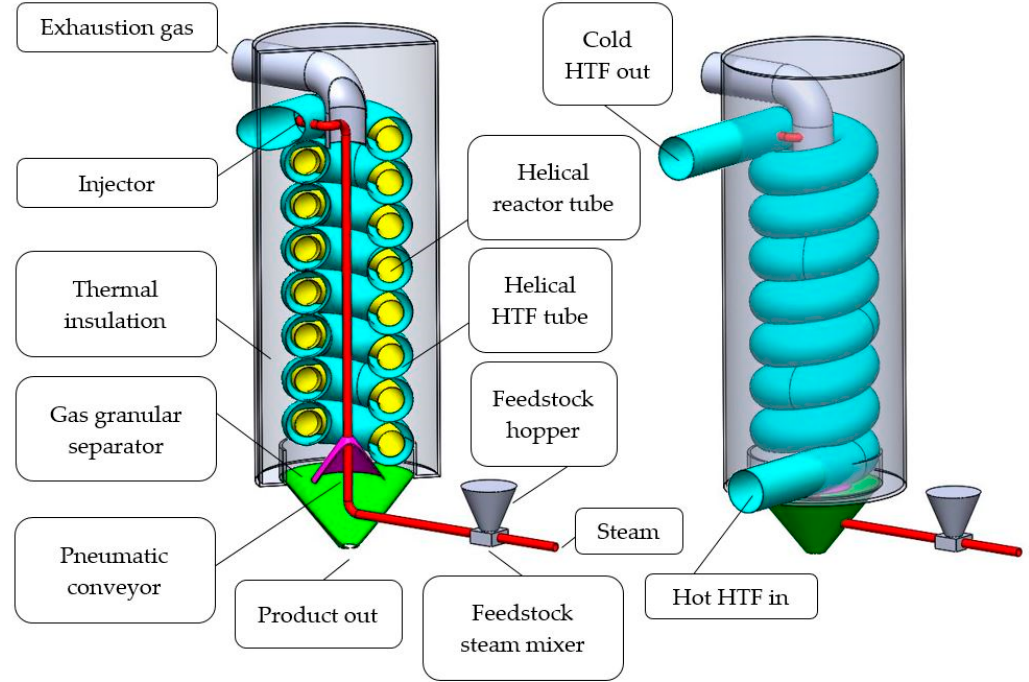
Figure 2. Isometric cut view ( left ) and isometric view ( right ) of one segment of the proposed tube-in-tube helical system for mineral calcination.